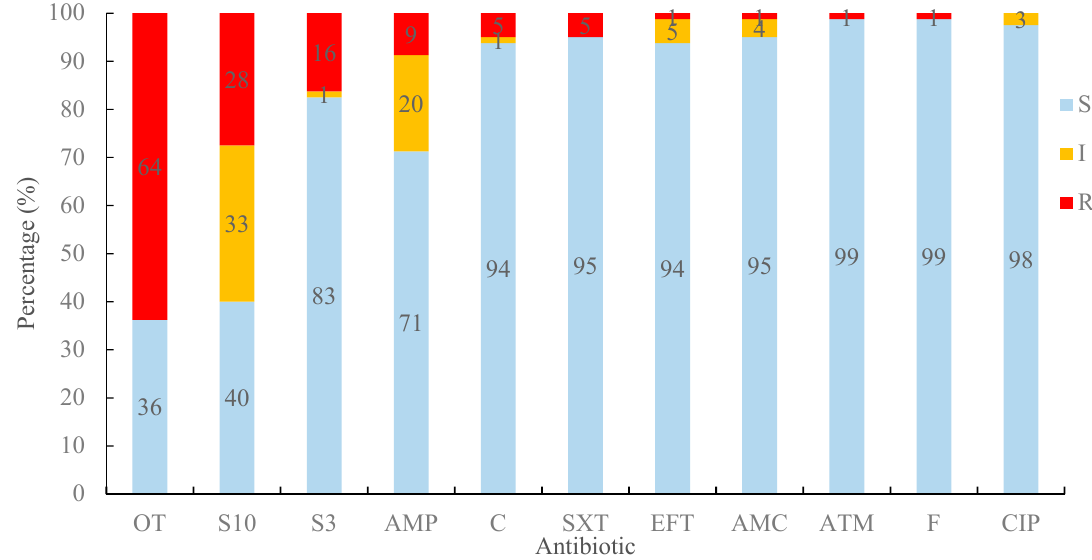
Figure 1. Percentage sensitivity to 18 antibiotics for 80 E. coli strains. Blue bars indicate sensitive (S), yellow bars indicate intermediate sensitivity (I), and red bars indicate lack of sensitivity (R), using Clinical and Laboratory Standards Institute (CLSI) definitions [39–41]. For antibiotic abbreviations, see Table 3.